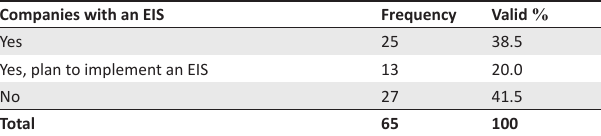
TABLE 1: Existence of Executive Information Systems (EISs) in Johannesburg Stock Exchange companies.